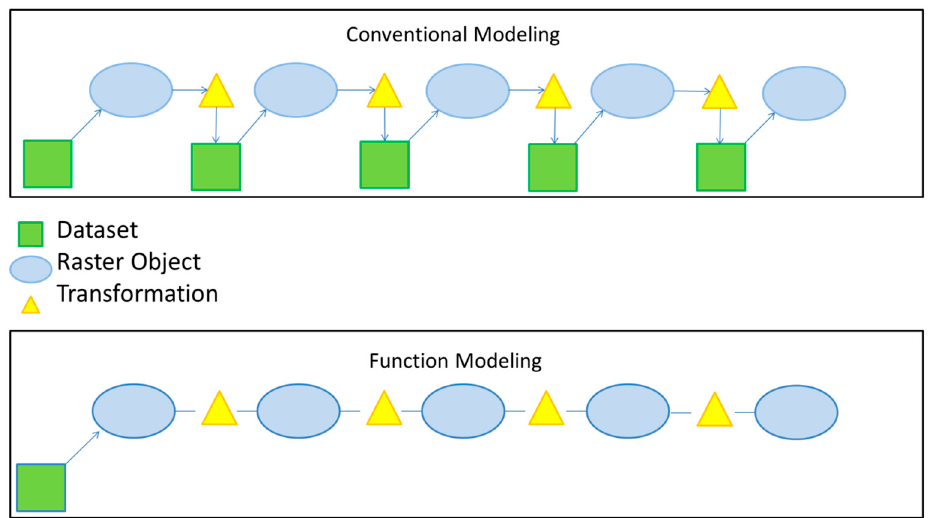
Figure 1. A schematic comparing conventional modeling (CM), which employs eager evaluation, to function modeling (FM), which uses lazy evaluation. The conceptual difference between the two modeling techniques is that FM delays evaluation until results are needed and produces results without storing intermediate data sets to disk (green squares). When input and output operations or disk storage space are the primary bottlenecks in running a spatial model, this difference in evaluation can substantially reduce processing time and storage requirements.